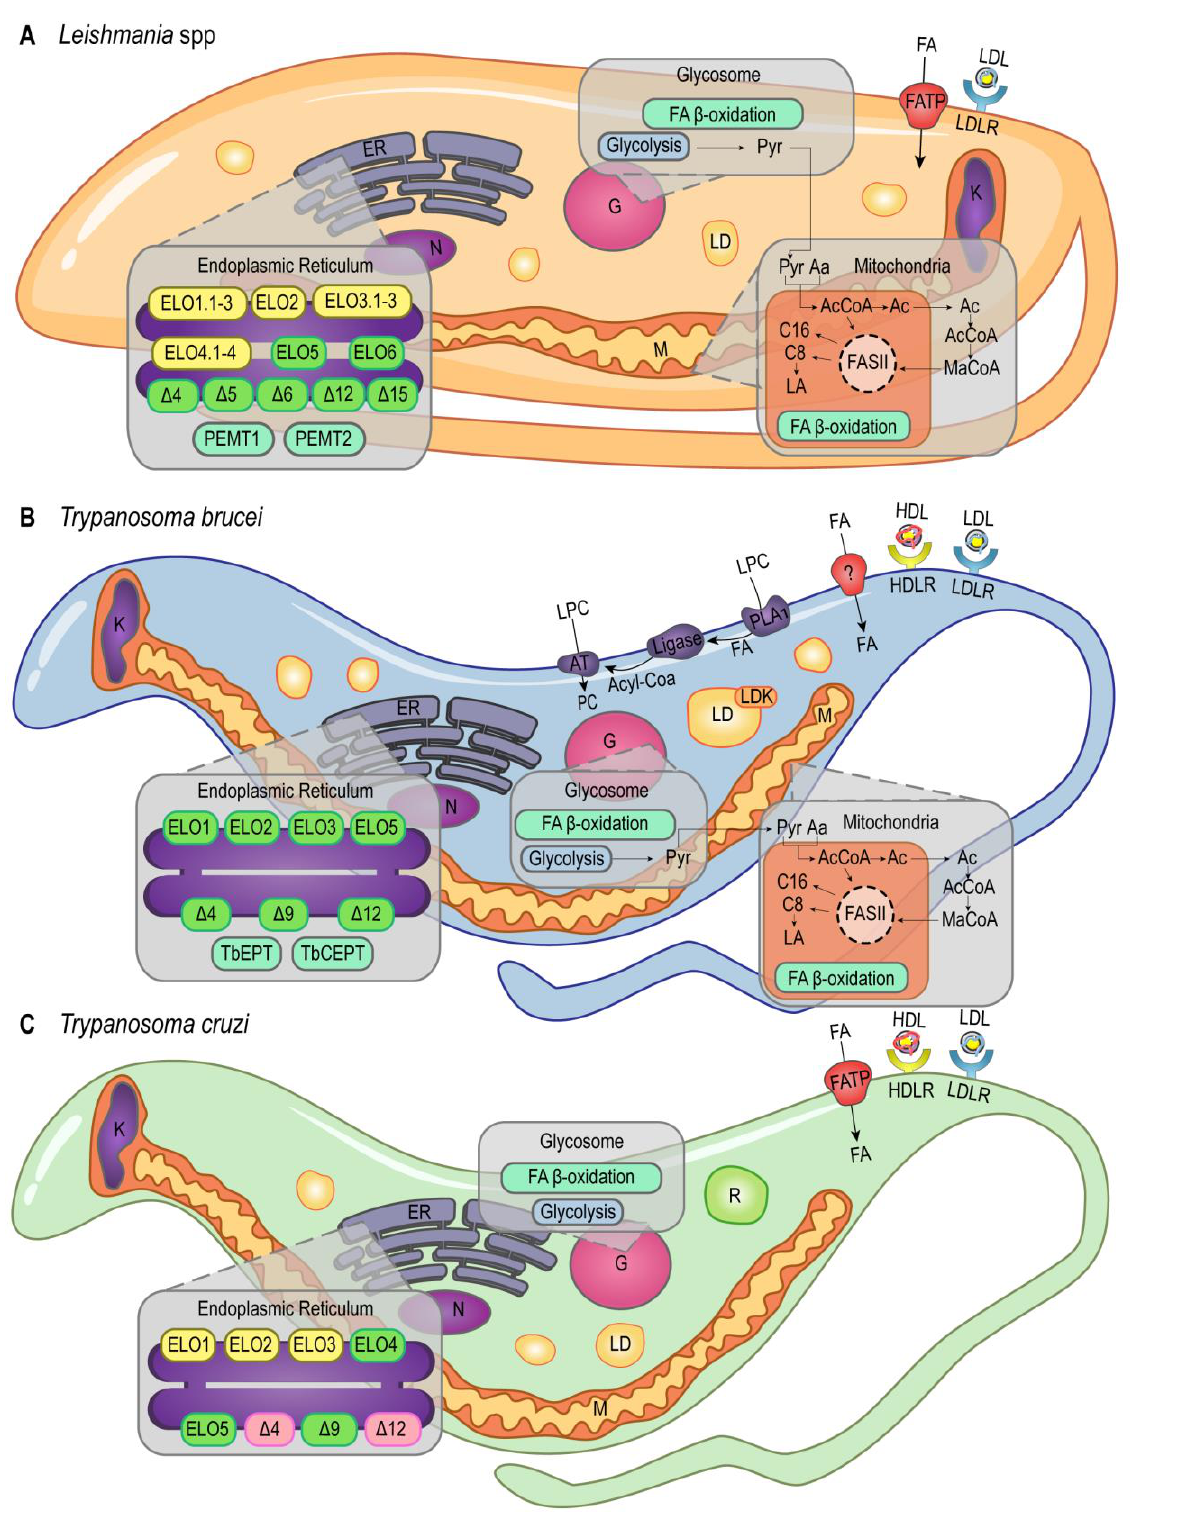
FIGURE 1: Lipid and FA pathways in Leishmania spp., T. brucei and T. cruzi . Schematic illustration of lipid and FA acquisition and metabolic pathways identified in Leishmania spp. (A) , T. brucei (B) and T. cruzi (C) . Aa - Aminoacid; AcCoA - Acetyl CoA; AT - Acetyltransferase; C8 - Octanoic acid; C16 - Palmitic acid; ELO1.1-3, ELO2, ELO3.1-3, ELO4.1-4, ELO5, ELO6 - Elongases; ER - Endoplasmic Reticulum; FA - Fatty Acid; FASII - Fatty Acid Synthase II; FAT - Fatty Acid Transporter; G - Glycosome; HDL - High Density Lipoprotein; HDLR - High Density Lipoprotein Receptor; K - Kinetoplast; LA - Lipoic acid; LD - Lipid Droplets; LDK - Lipid Droplet Ki- nase; LDL - Low Density Lipoprotein; LDLR - Low Density Lipoprotein Receptor; LPC - Lysophosphatidylcholine; M - Mitochondria; MaCoA - Malonyl-CoA; N - Nucle- us; PC - Phosphatidylcholine; PEMT1 - Phosphatidylethanolamine Methyltransferase 1; PEMT2 - Phosphatidylethanolamine Methyltransferase 2; PLA1 - Phospho- lipase 1; Pyr - Pyruvate; R - Reservosomes; TbCEPT - Choline/Ethanolamine Phosphotransferase; TbEPT - Ethanolamine Pphosphotransferase; Δ4 - 6, Δ9, Δ12, Δ15 – Desaturases. Yellow boxes, Leishmania spp. putative genes (ELO1.1-3, ELO2, ELO3.1-3, ELO4.1-4 in A). Green boxes, characterized proteins (ELO5, ELO6 and de- saturases in A; ELO1, ELO2, ELO3, ELO5 and desaturases in B; ELO5 and Δ9 in C). Pink boxes, protein activity de tected in T. cruzi (Δ4 and Δ12 in